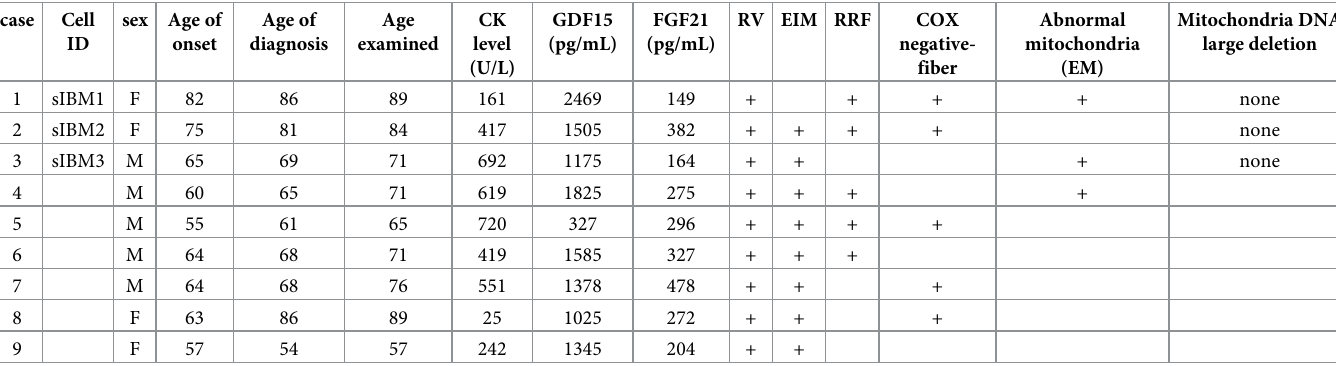
Table 1. Characteristics of sIBM patients.